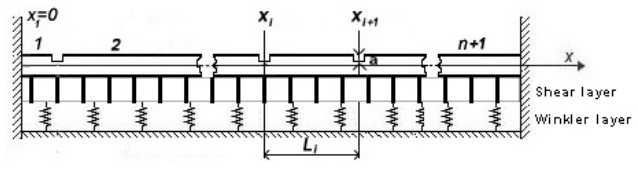
Fig. 1. A clamped beam on the Pasternak foundation.